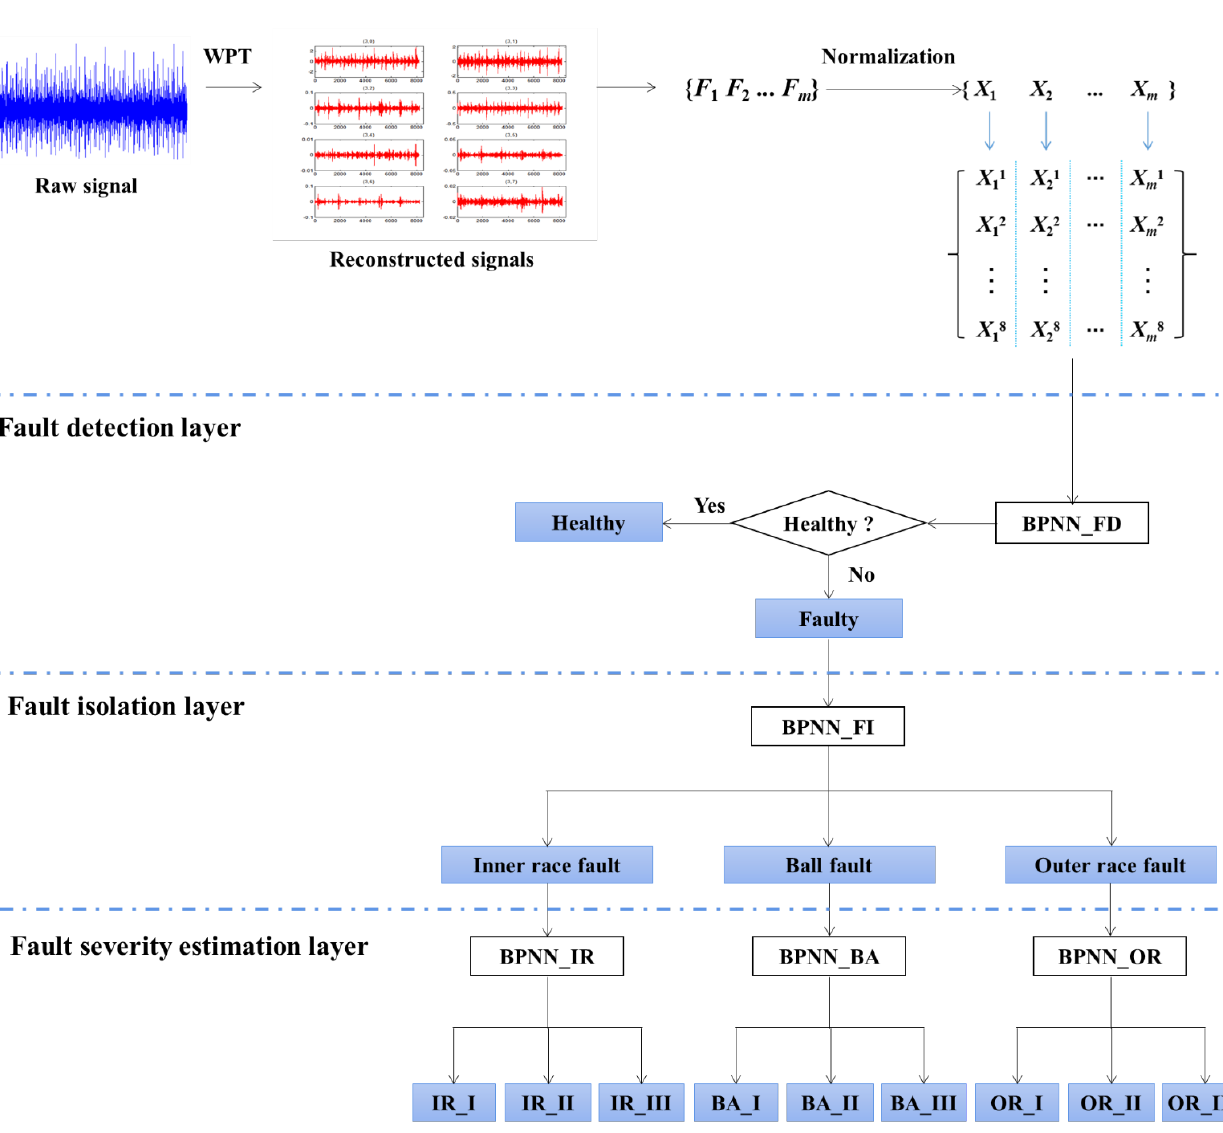
Figure 5. Hierarchical diagnostic flowchart of rolling bearings.